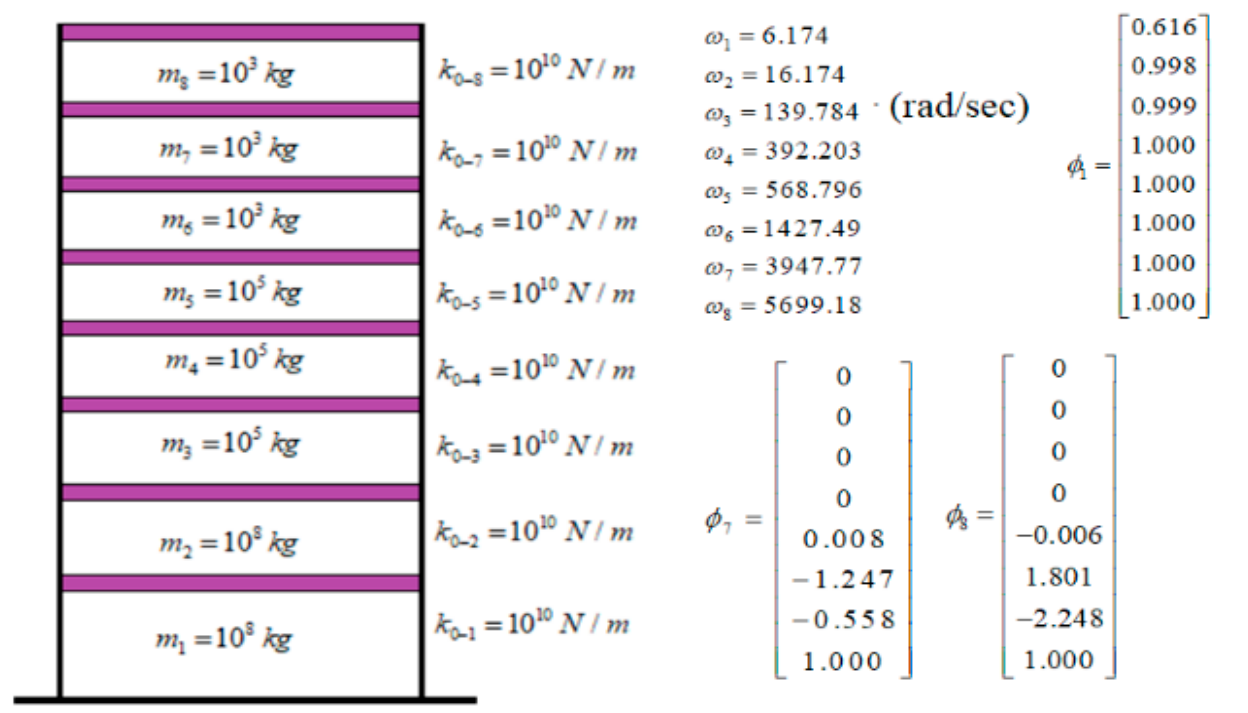
Figure 13. A linear elastic system and a nonlinear system are simulated by specifying ap- propriate q values, which are given as below